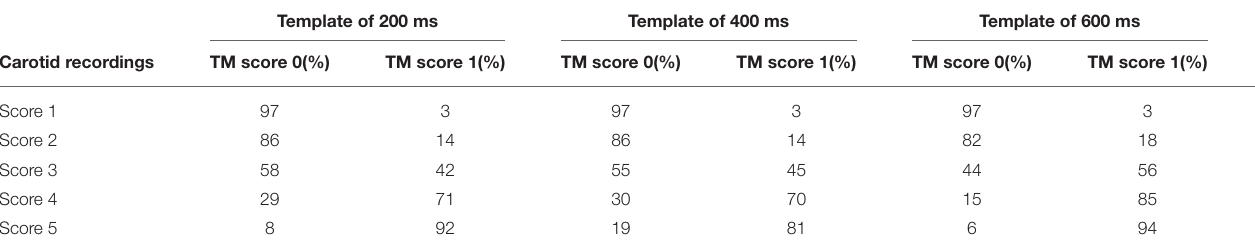
TABLE 2 | Confusion matrices of signal classification done by the hand-engineered classification model constructed with template matching. Template of 200 ms Template of 400 ms Template of 600